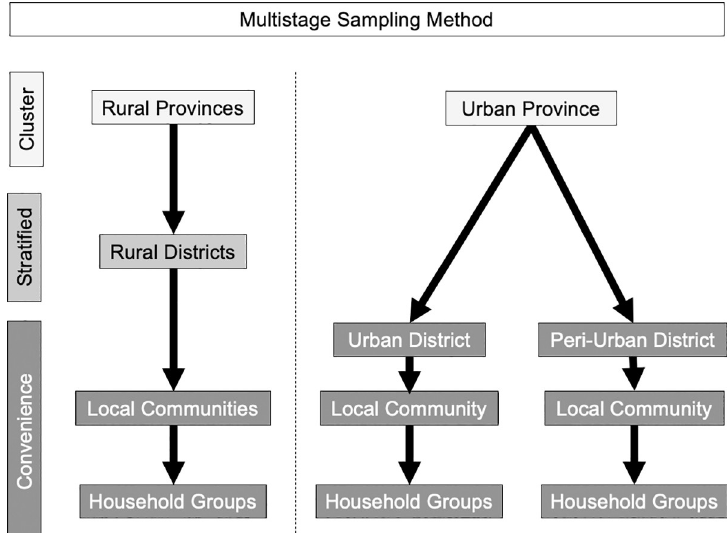
Fig 1. Sample strategy for household selection in rural, peri-urban and urban study sites of